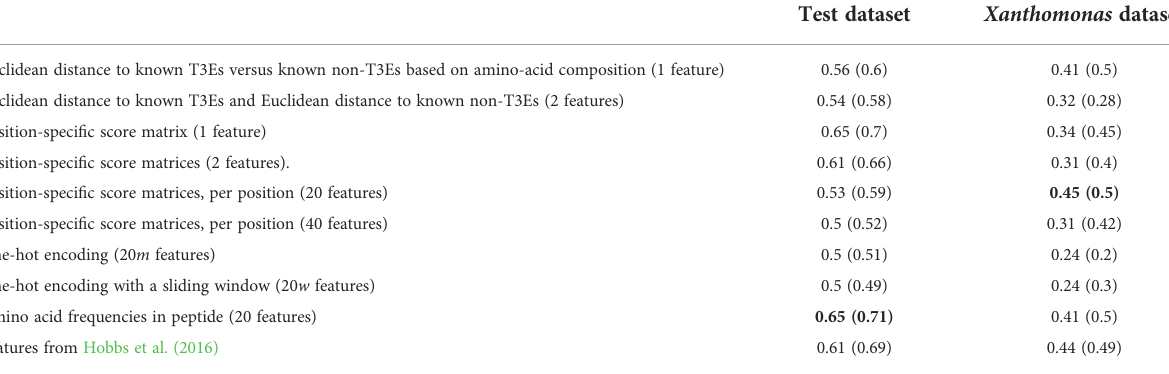
TABLE 2 The performance of alternative methods to model the secretion